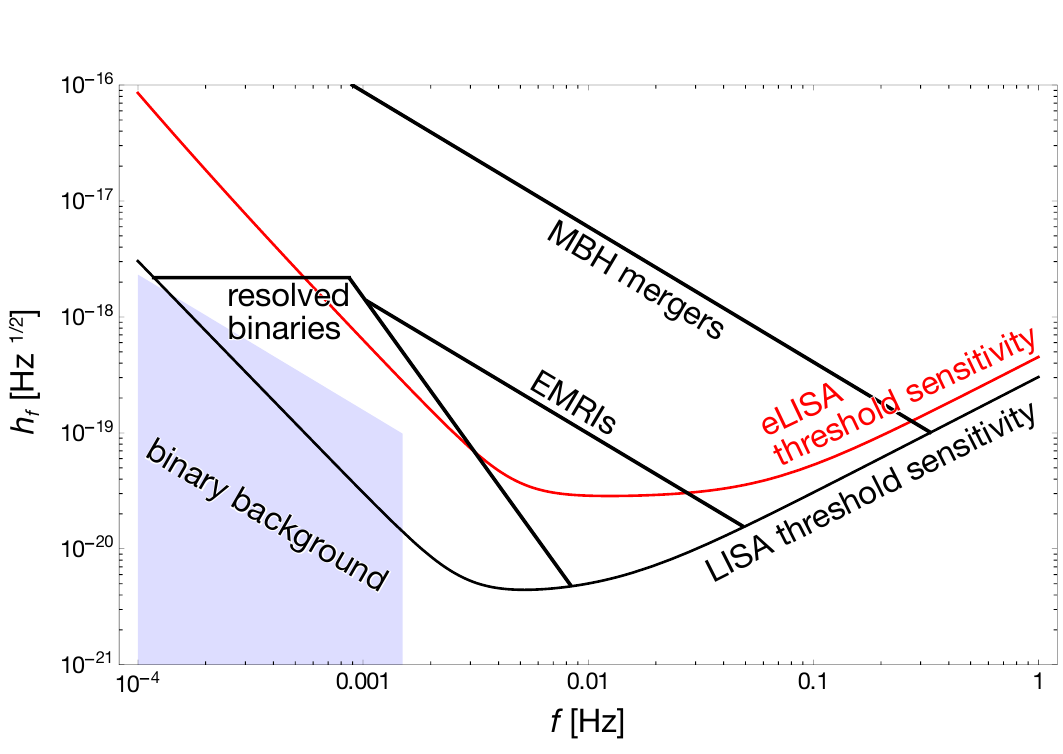
Figure 2: The discovery space for space-based GW detectors, covering the low-frequency region of the GW spectrum, 10 − 5 Hz (cid:46) 𝑓 (cid:46) 0 . 1 Hz. The discovery space is delineated by the LISA threshold sensitivity curve [277] in black, and by the eLISA sensitivity curve in red [21] (the curves were produced using the online sensitivity curve and source plotting website [321]). This region is populated by a wealth of strong sources, often in large numbers, including mergers of MBHs, EMRIs of stellar-scale compact objects into MBHs, and millions of close-orbiting binary systems in the galaxy. Thousands of the strongest signals from these galactic binary systems should be individually resolvable, while the combined signals of millions of them produce a stochastic background at low frequencies. These systems provide ample opportunities for astrophysical tests of GR for gravitational-field strengths that are not well characterized and studied in conventional